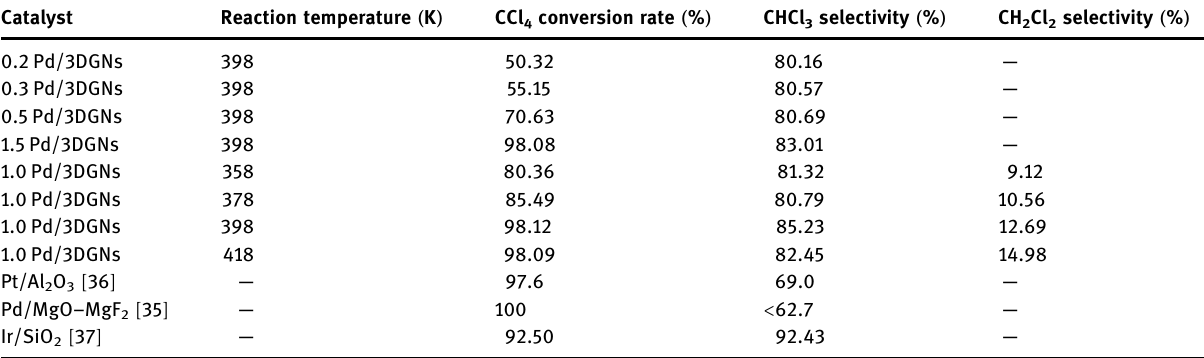
Table 2: Comparison of activity and selectivity of di ff erent catalytic systems for hydrogenation of carbon tetrachloride